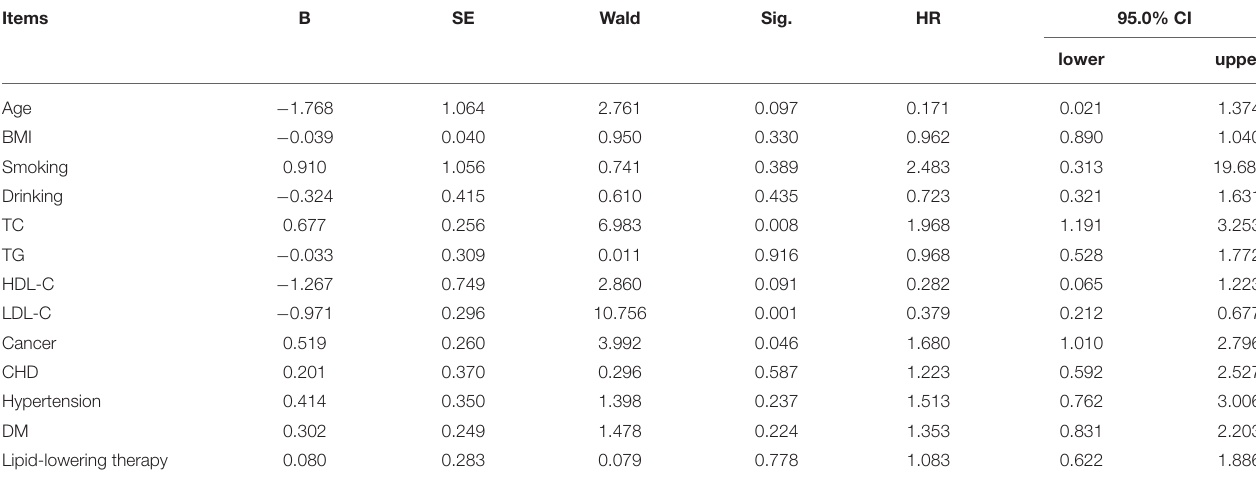
TABLE 3 | The multivariate analysis in 121 centenarians. Items B SE Wald Sig. HR 95.0% CI